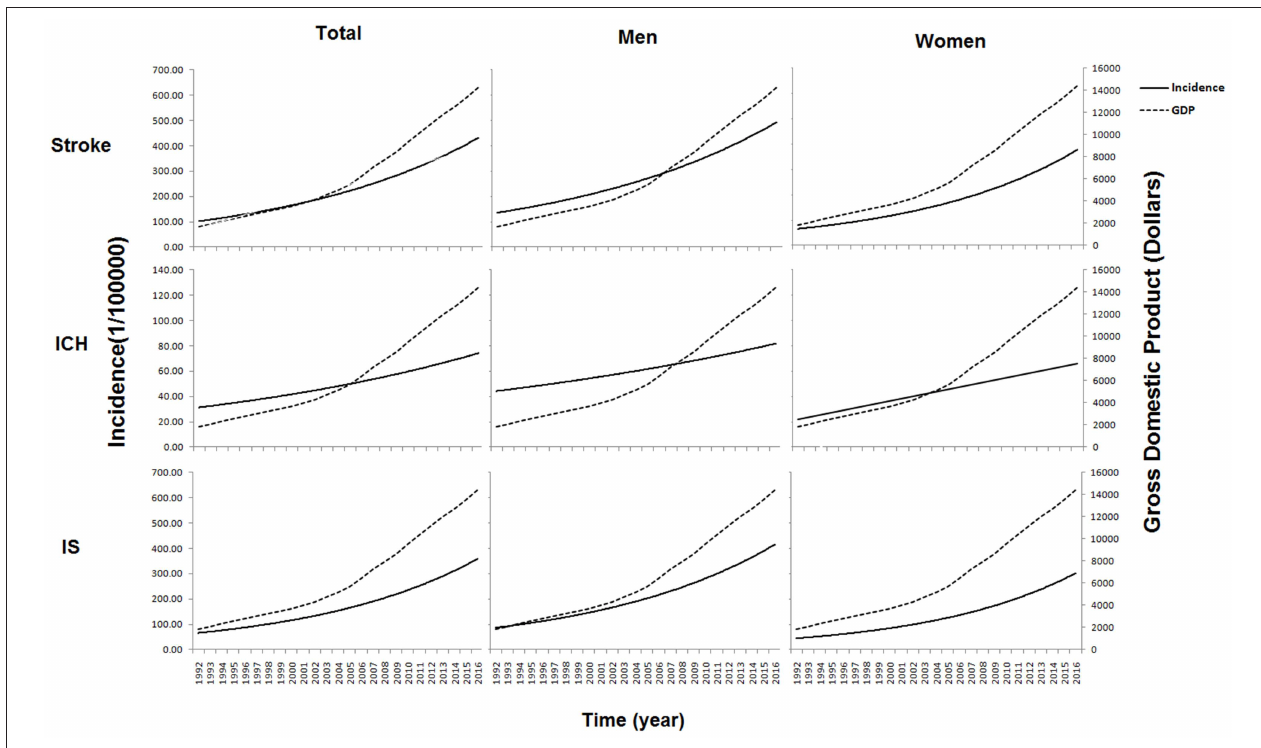
FIGURE 2 | Association of GDP with stroke incidence over time during the 25-year study period. It shows that the first-ever stroke incidence increased by 10.7% per 1,000 dollars increase in PPP-aGDP overall during the 25-year study period, with increases of 9.6% (6.8 to 12.4%) in men and 13.0% (9.0 to 16.9%) in women (all P < 0.001). With regard to stroke types, incidence increased by 6.2% (95%CI: 1.6 to 10.8%; P = 0.011) for ICH and 12.6% (95%CI: 9.7 to 15.6%; P < 0.001) for IS following 1,000 dollars increasing of